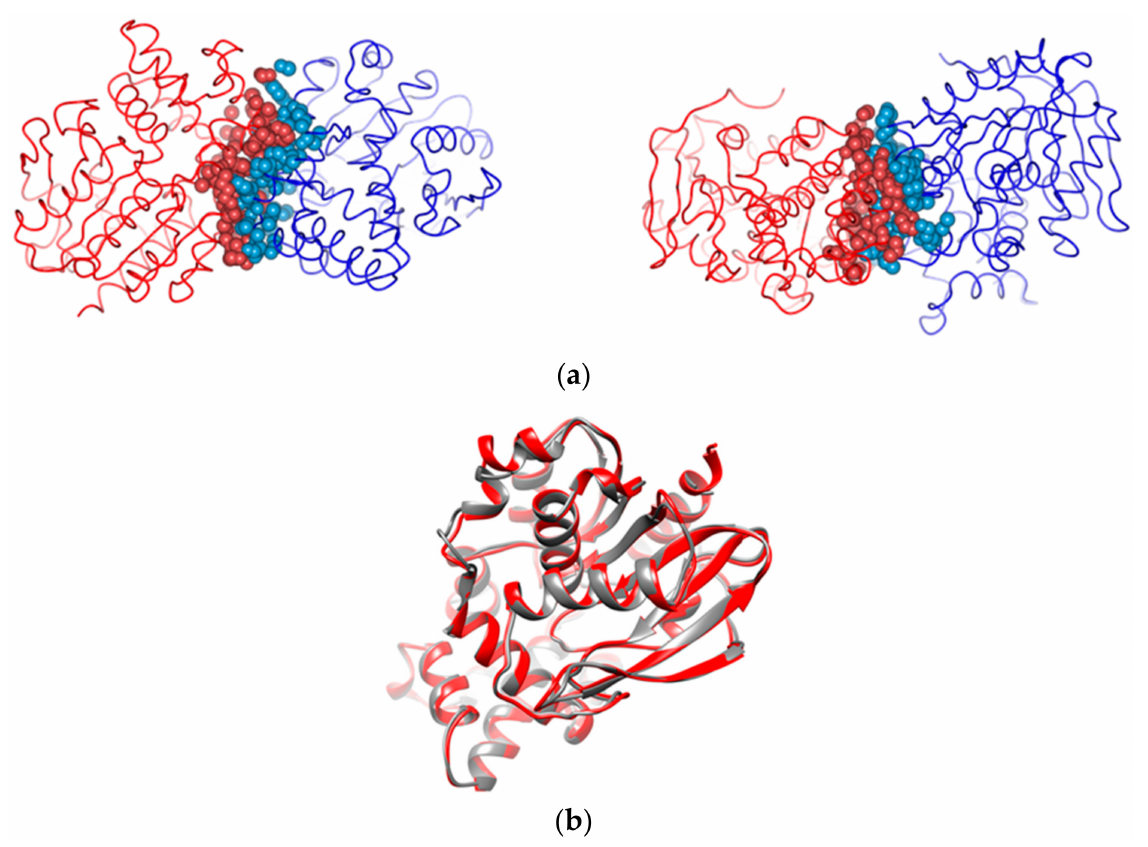
Figure 8. ( a ) The dimeric assemblies of Ga PIP at different orientations. Atoms involved in dimer formations are highlighted in spheres. Each colour represents one monomer. ( b ) Superimposed structures of the solved Ga PIP–5YHP (red ribbon) and the 1AZW structure (grey ribbon) at an RMSD of 0.6